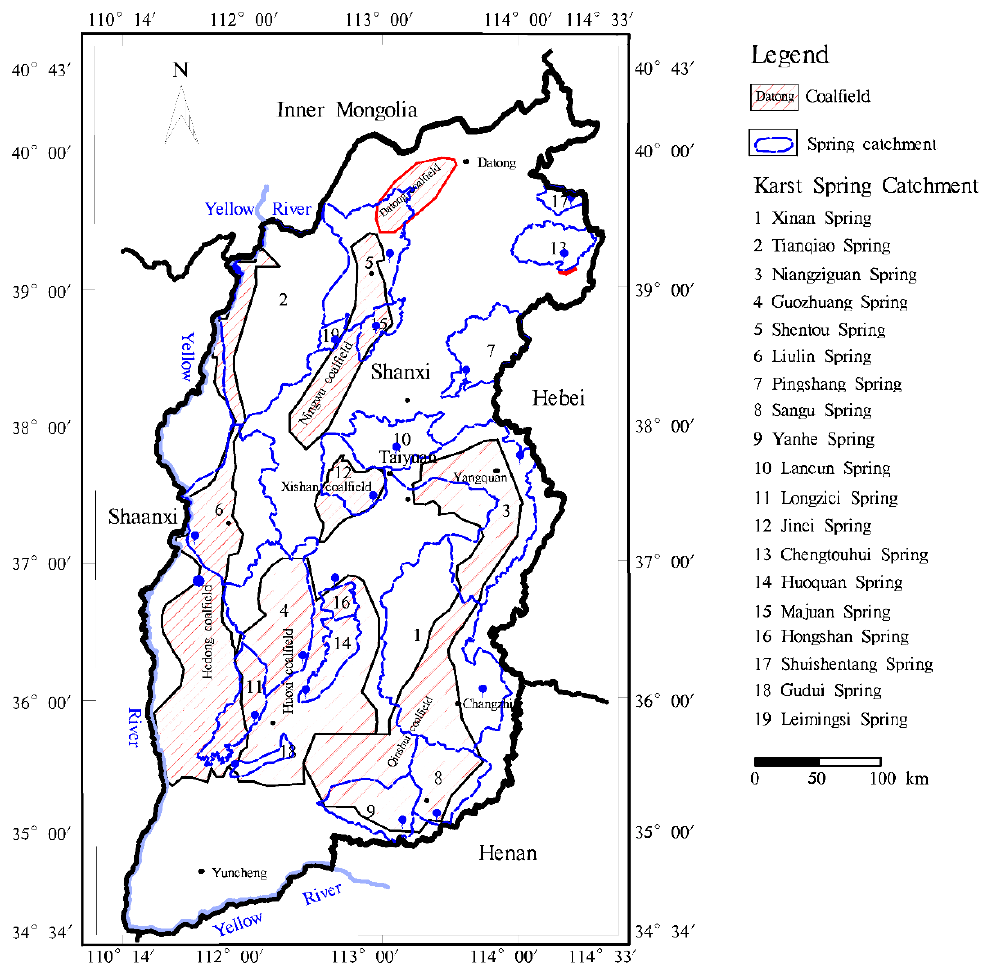
Figure 2. The 19 major karst springs in Shanxi.